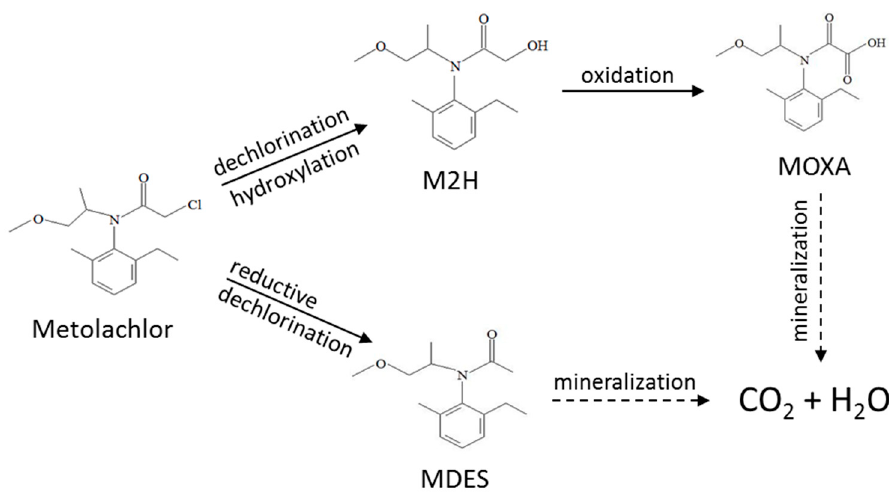
Figure 6. Proposed metabolic pathway of metolachlor by P. oxalicum sp. strain MET-F-1.